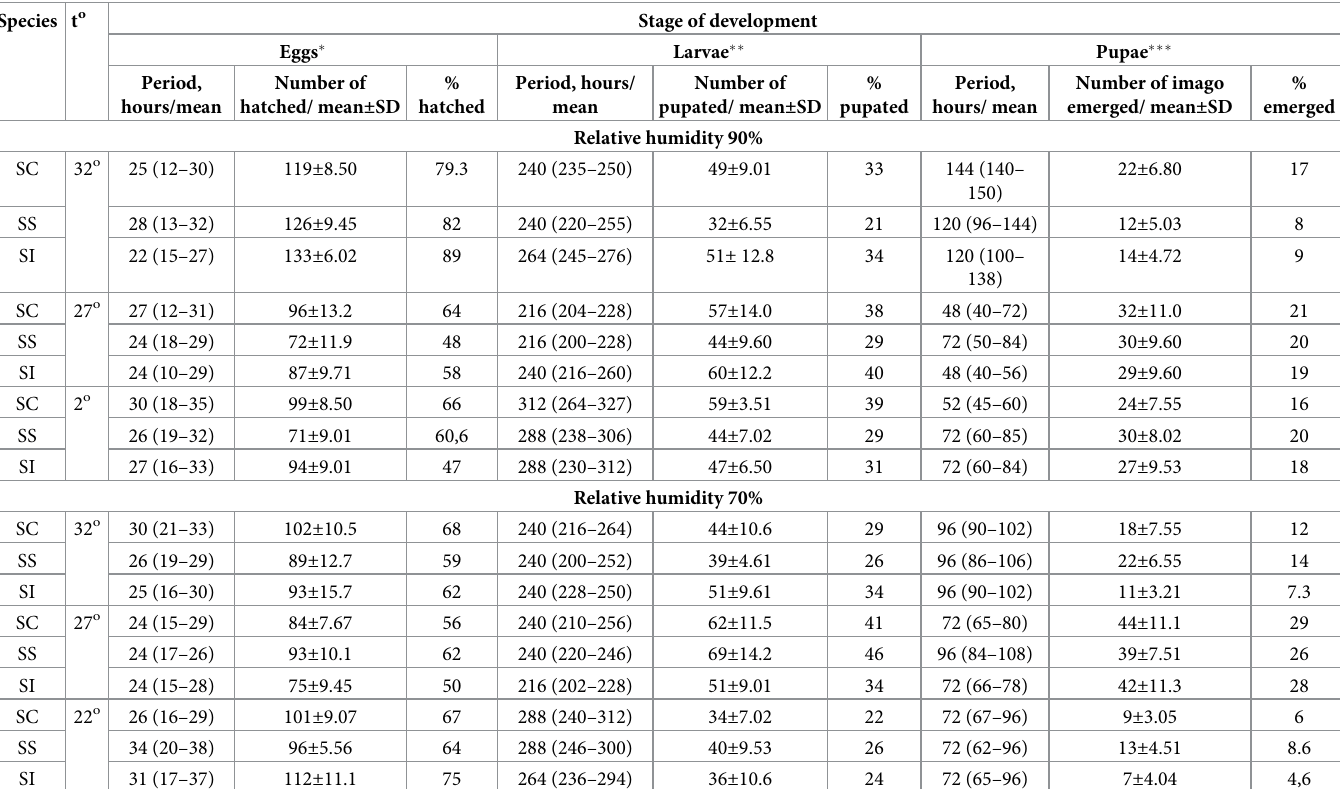
Table 2. Summary of incubation parameters affecting on immature forms of Stomoxys species.